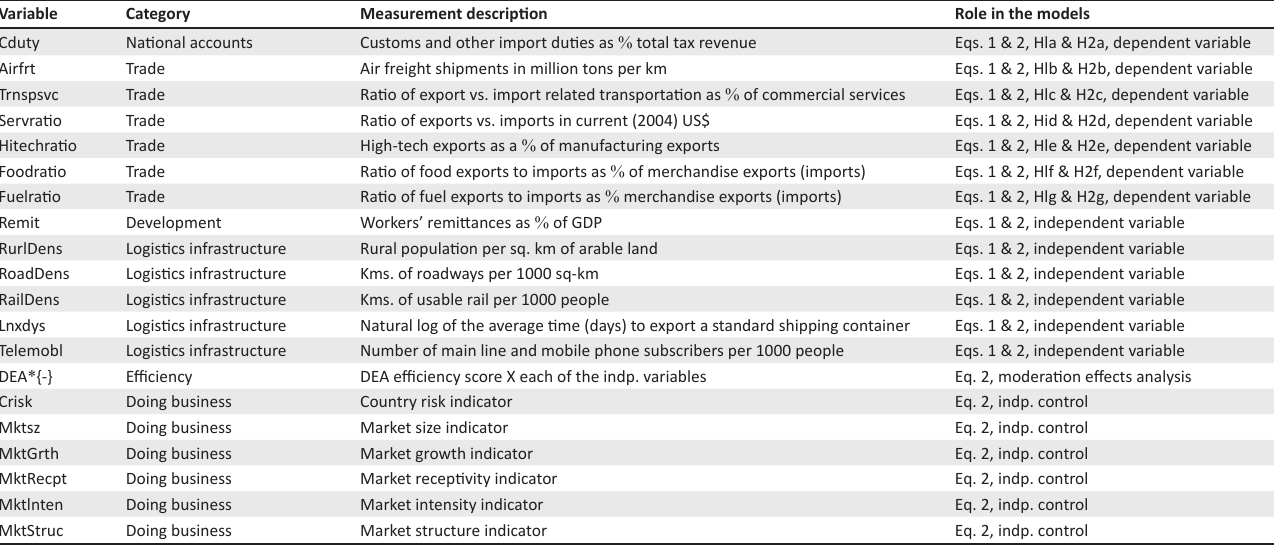
TABLE 1: Definition of